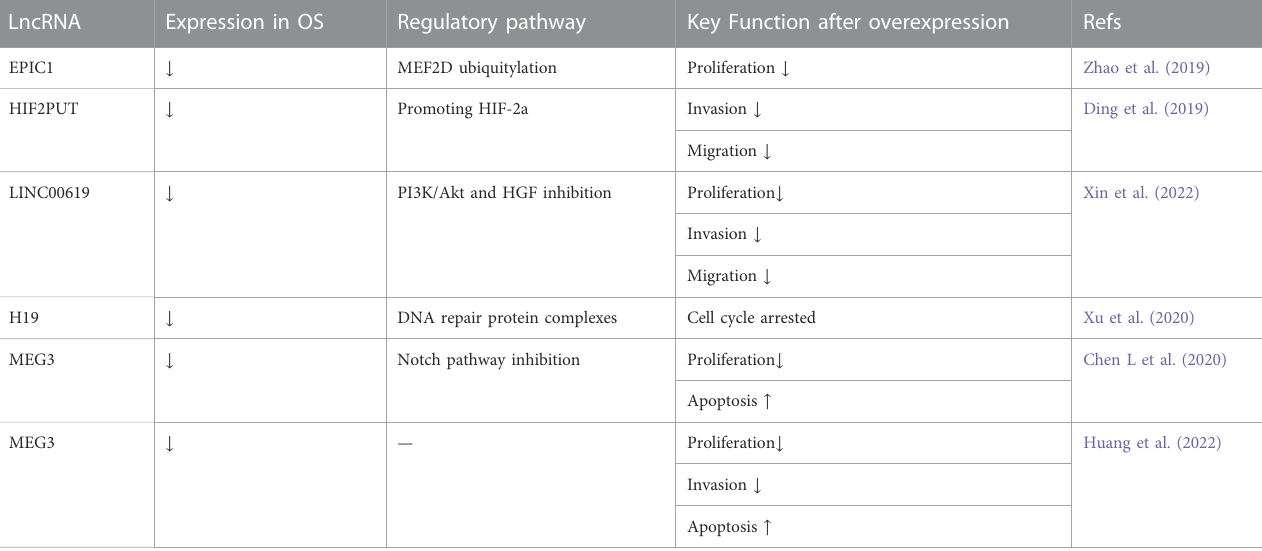
TABLE 8 Tumor suppressive lncRNAs associated with osteosarcoma inhibition by mechanisms other than miRNAs.